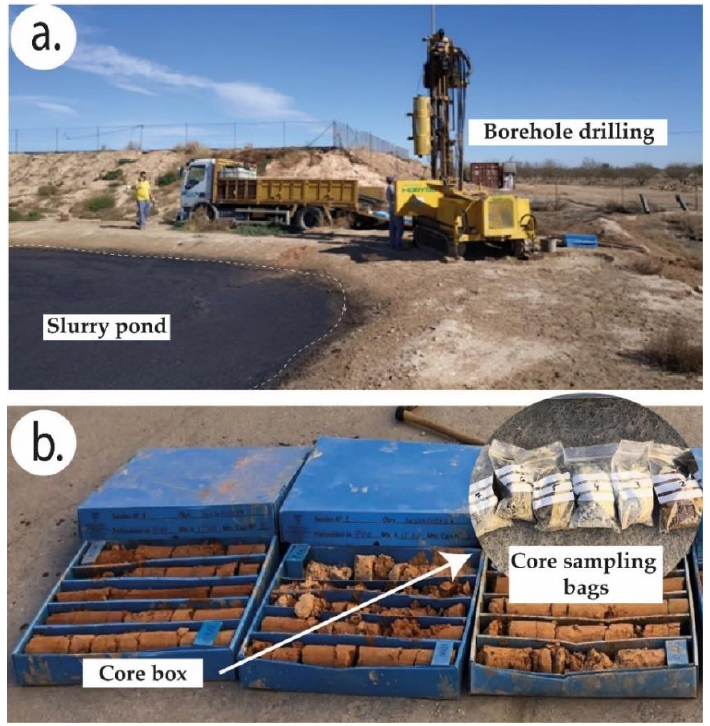
Figure 5. ( a ) Drilling operation at the slurry pond; ( b ) core samples collected from a